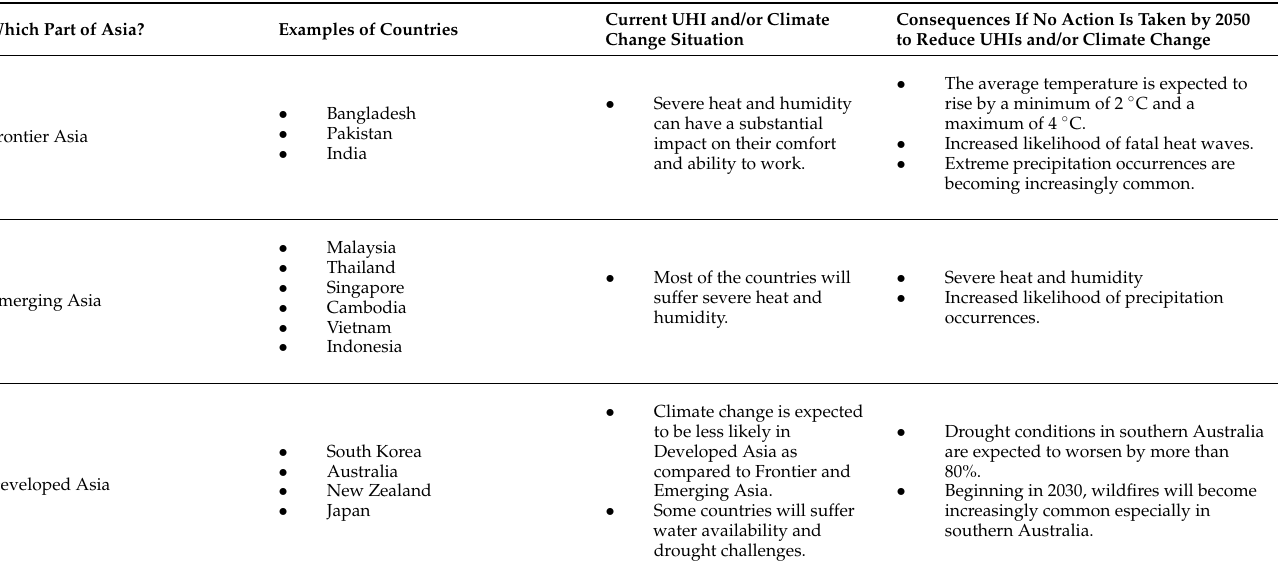
Table 1. A summary of the current situation in various parts of Asia, as well as the ramifications if nothing is done to prevent UHIs and/or climate change by 2050